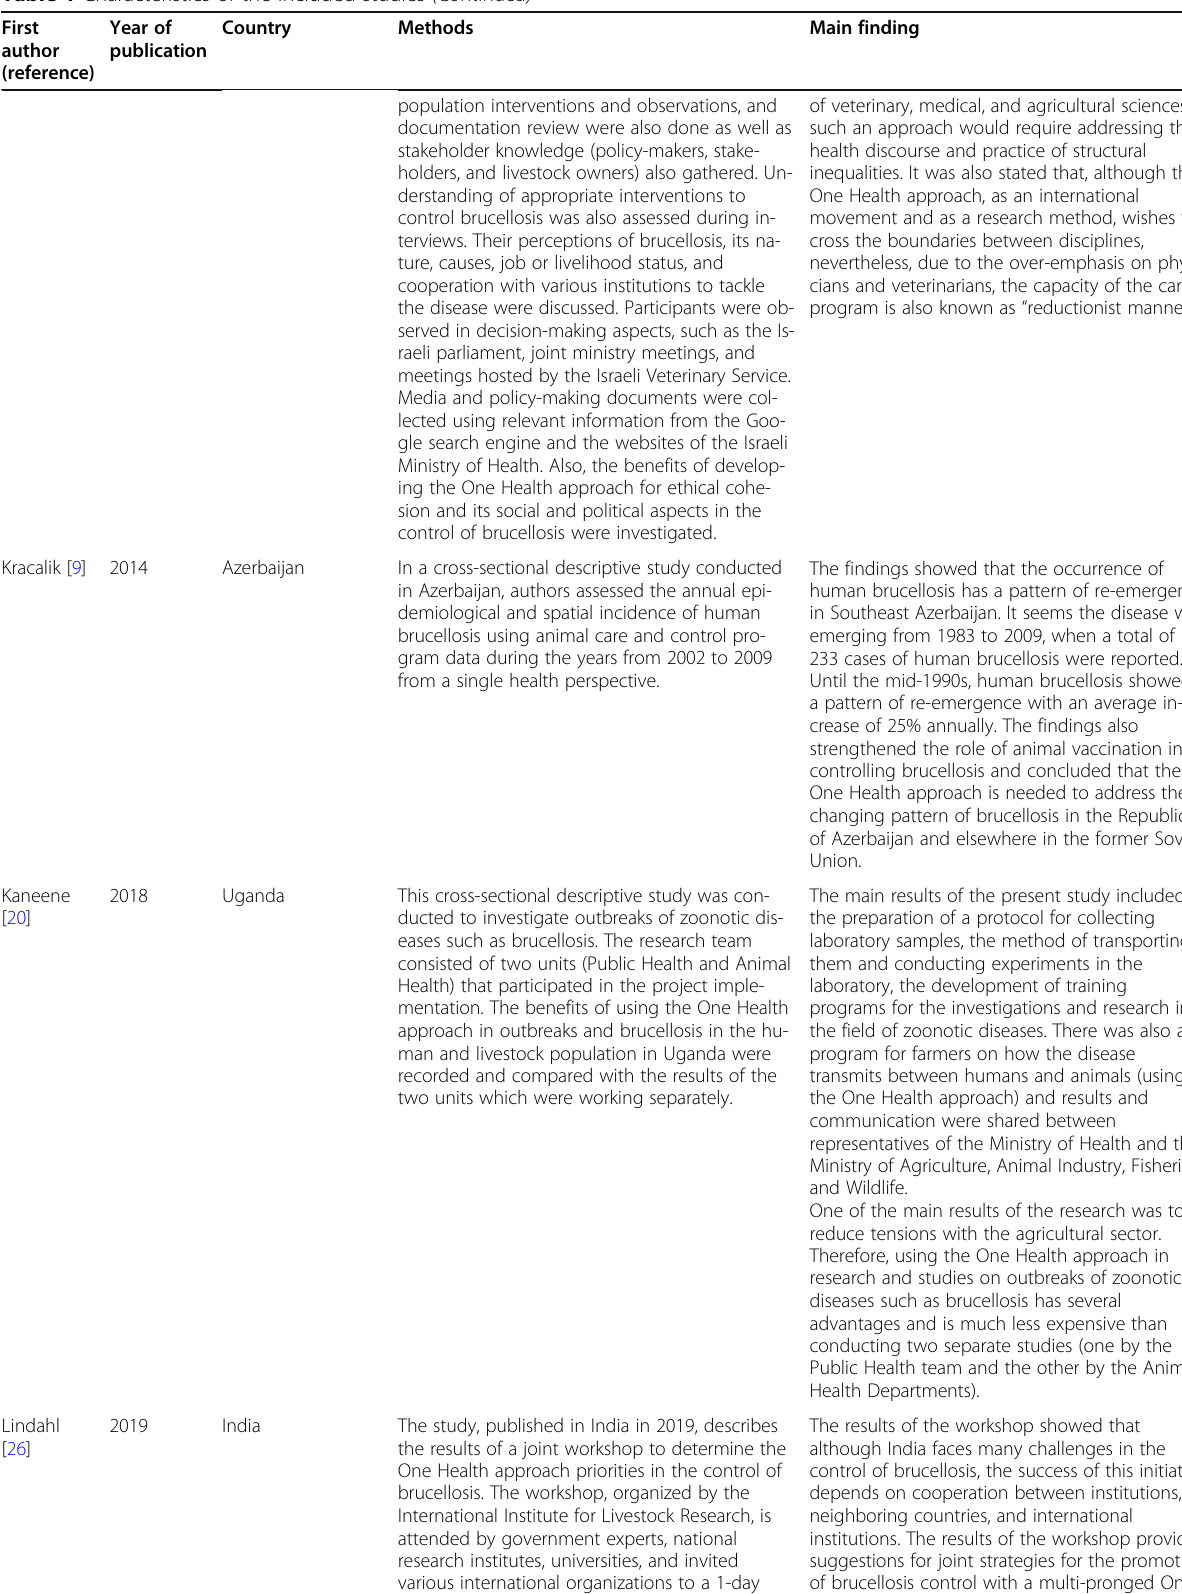
Table 1 Characteristics of the included studies